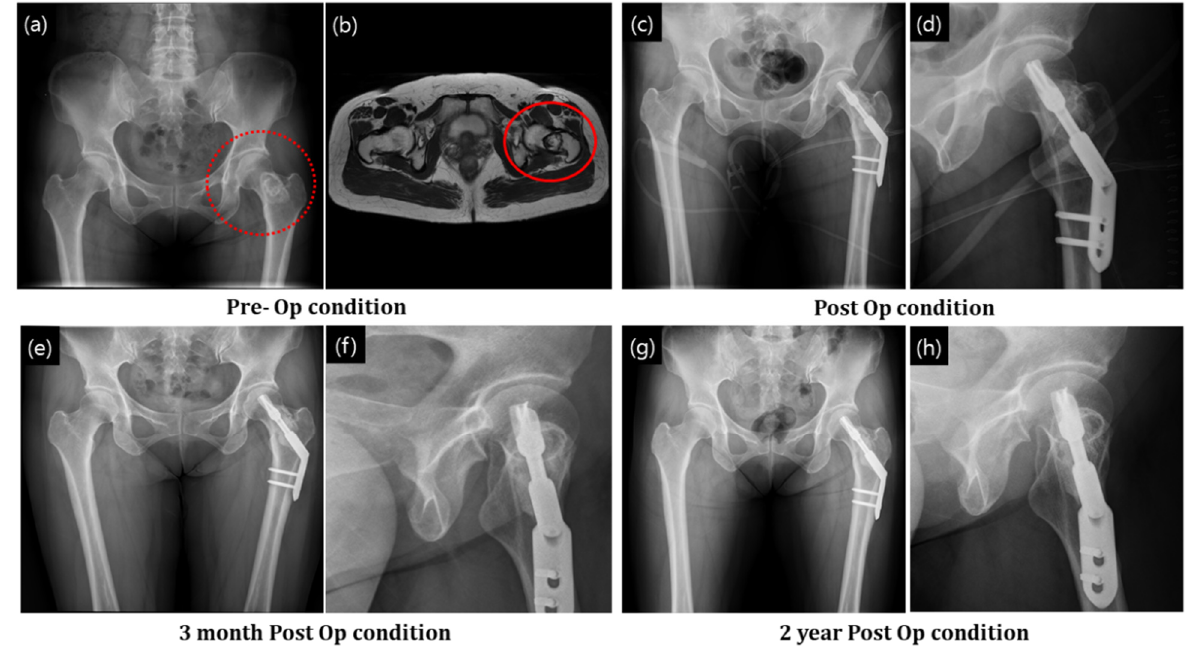
Figure 5. Simple bone cyst in the intertrochanter region of the femur was removed and granular bone substitute used for bone regeneration. ( a , b ) X-ray and MRI diagnosis of the bone cyst, ( c , d ) postop condition with application of granular bone substitute and support implant, ( e , f ) after 3 months of operation and ( g , h ) after 3 years of operation. The red circles indicate implanted defect zone.